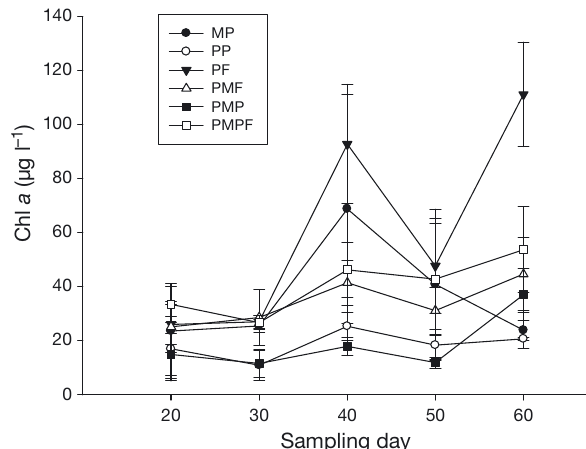
Fig. 3. Temporal dynamics of chlorophyll a in different treatments during the experiment. Data are presented as means ± SE. Treatment groups are defined in Table 1